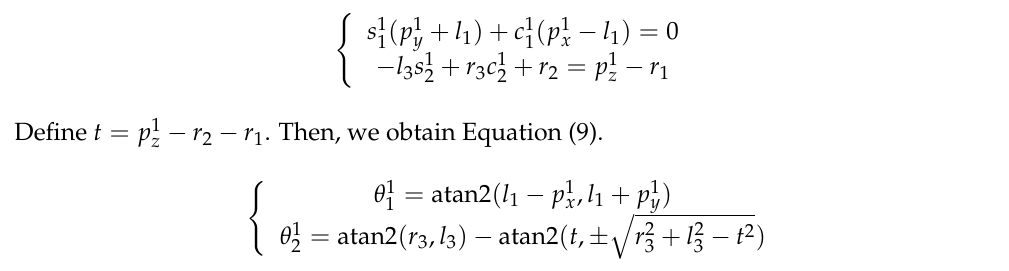
( d ) Figure 7. The sequence of the gaits. ( a ) TPWG; ( b ) TTWG; ( c ) SSGTL; ( d ) the synchronous sliding gait with four legs. The gray and the black bars show that the leg is in the transfer and support phase, respectively. Over single cycles of the trotting and synchronous gaits, the robot simultaneously has two legs in the transfer phase and two legs in the support phase. When in the synchronous sliding gait, the four legs of the robot swing synchronously with the same stride, generating different types of locomotion (rotatory or forward, based on different leg swing directions). Over a single cycle of TPWG, only one leg is in the transfer phase and, under the same conditions, the cycle time is twice that of the other three synchronous gaits. 3.4. Underwater Locomotion Every water-jet thruster of four legs can rotate in the vertical and horizontal planes. With the directions and propulsive forces of four vectored water-jet thrusters changing, the robot can move forward or backward, turn left or right, float or sink in the underwater environment. Figure 8 illustrates the underwater locomotion of the robot. The four legs are denoted by number 1, 2, 3 and 4, as shown in Figure 8d. Leg 1 and 2 are on the left of the robot, and leg 3 and 4 on the right. As depicted in Figure 8a,d, the robot can adjust the water-jet direction of thrusters in the same horizontal plane to realize forward or backward motion. In addition, by the difference of the left water-jet force and the right water-jet force, the robot can implement the left and right turning motion, as shown in Figure 8e,f. Besides, as shown in Figure 8b,c, with adjusting the direction and force of four water-jet thrusters in the vertical plane, the robot can float upward and sink down. With the flexible motion, our robot can be used for environment monitoring, object tracking and detection of pollution with proper sensors. ( a )